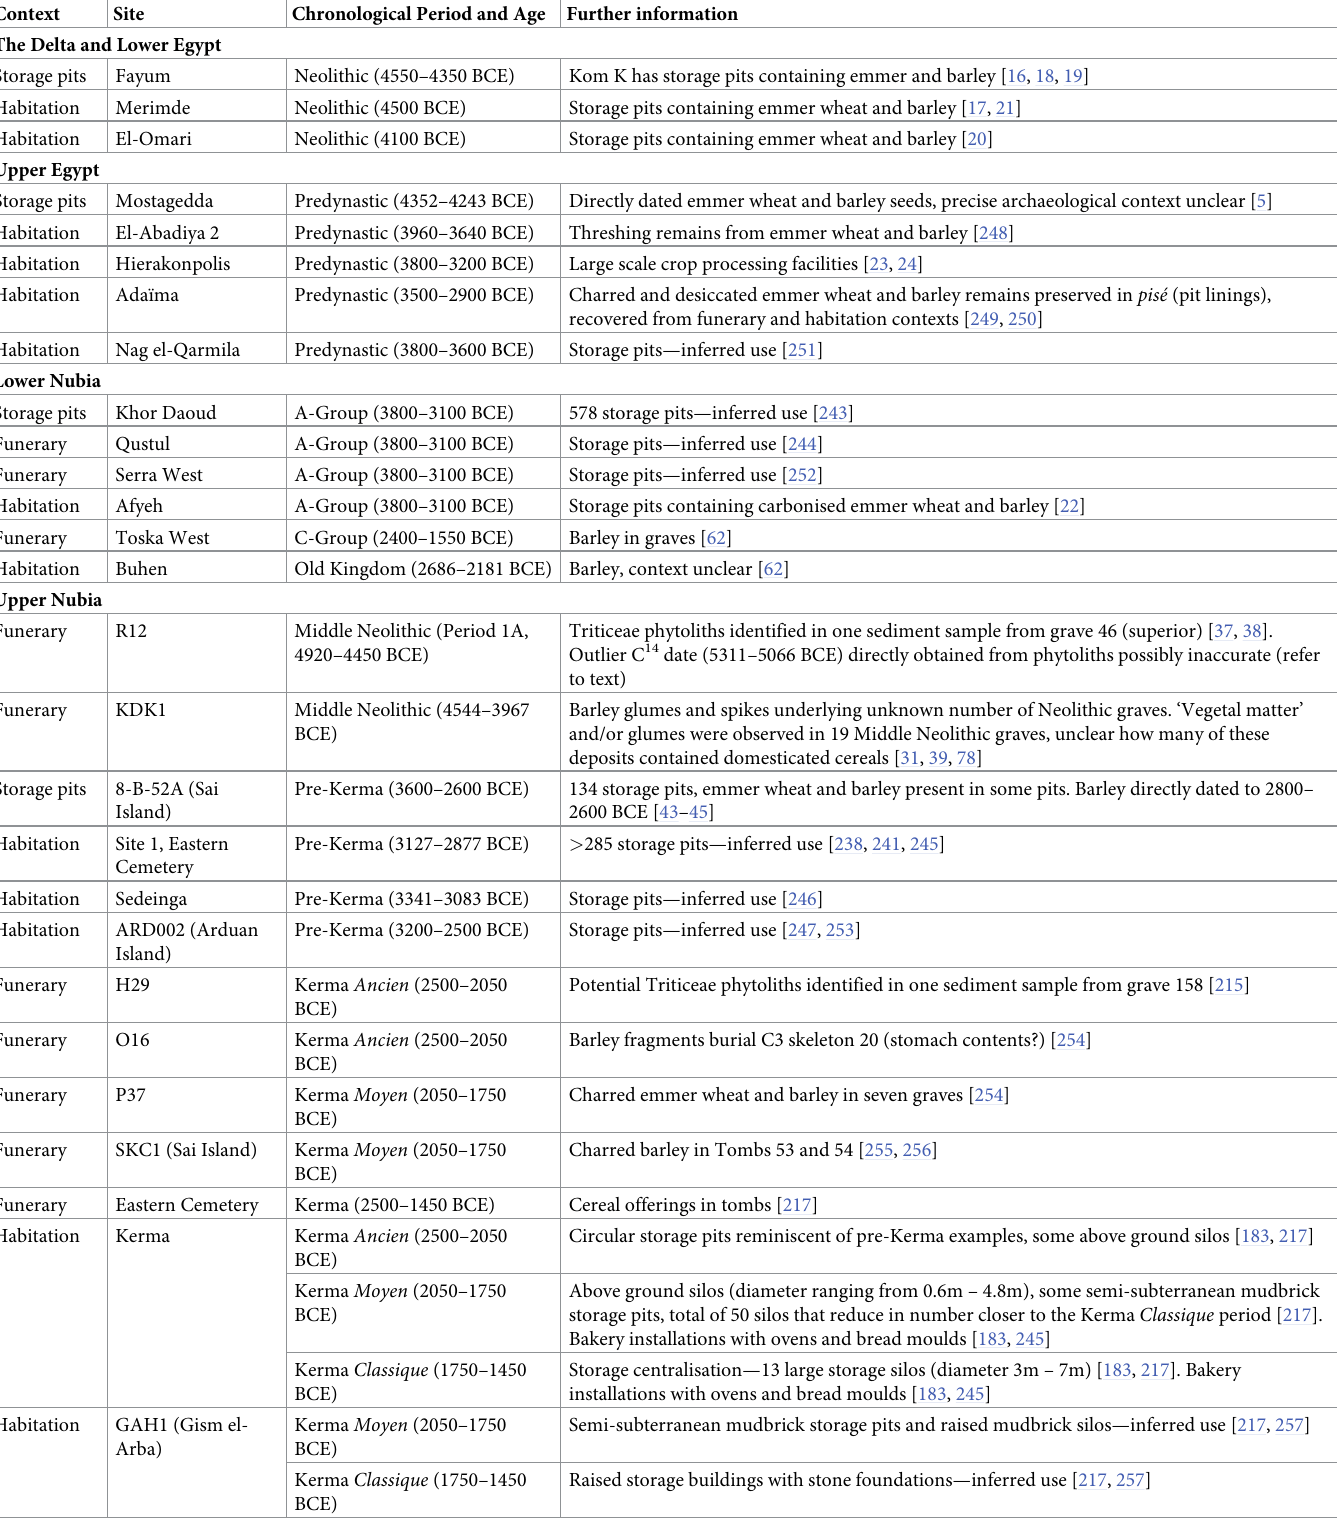
Table 3. Summary of early archaeological evidence for Southwest Asian cereals in the Nile Valley prior to New Kingdom conquest 1500